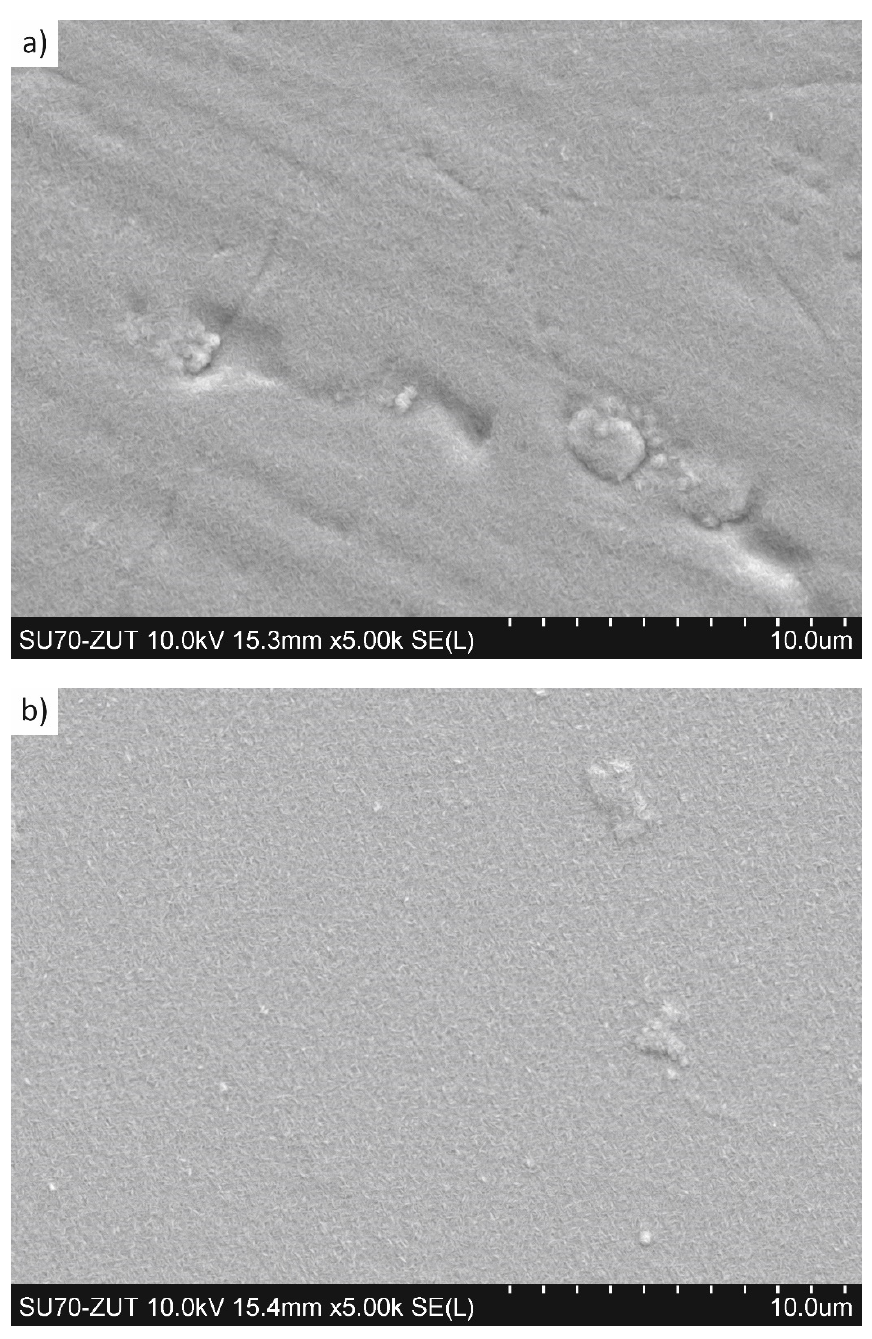
Figure 3. To surface view of S-phase (50 vol.% of N 2 )/Cr 2 N coating deposited on: ( a ) substrate in delivery state, ( b ) polished substrate, SEM.